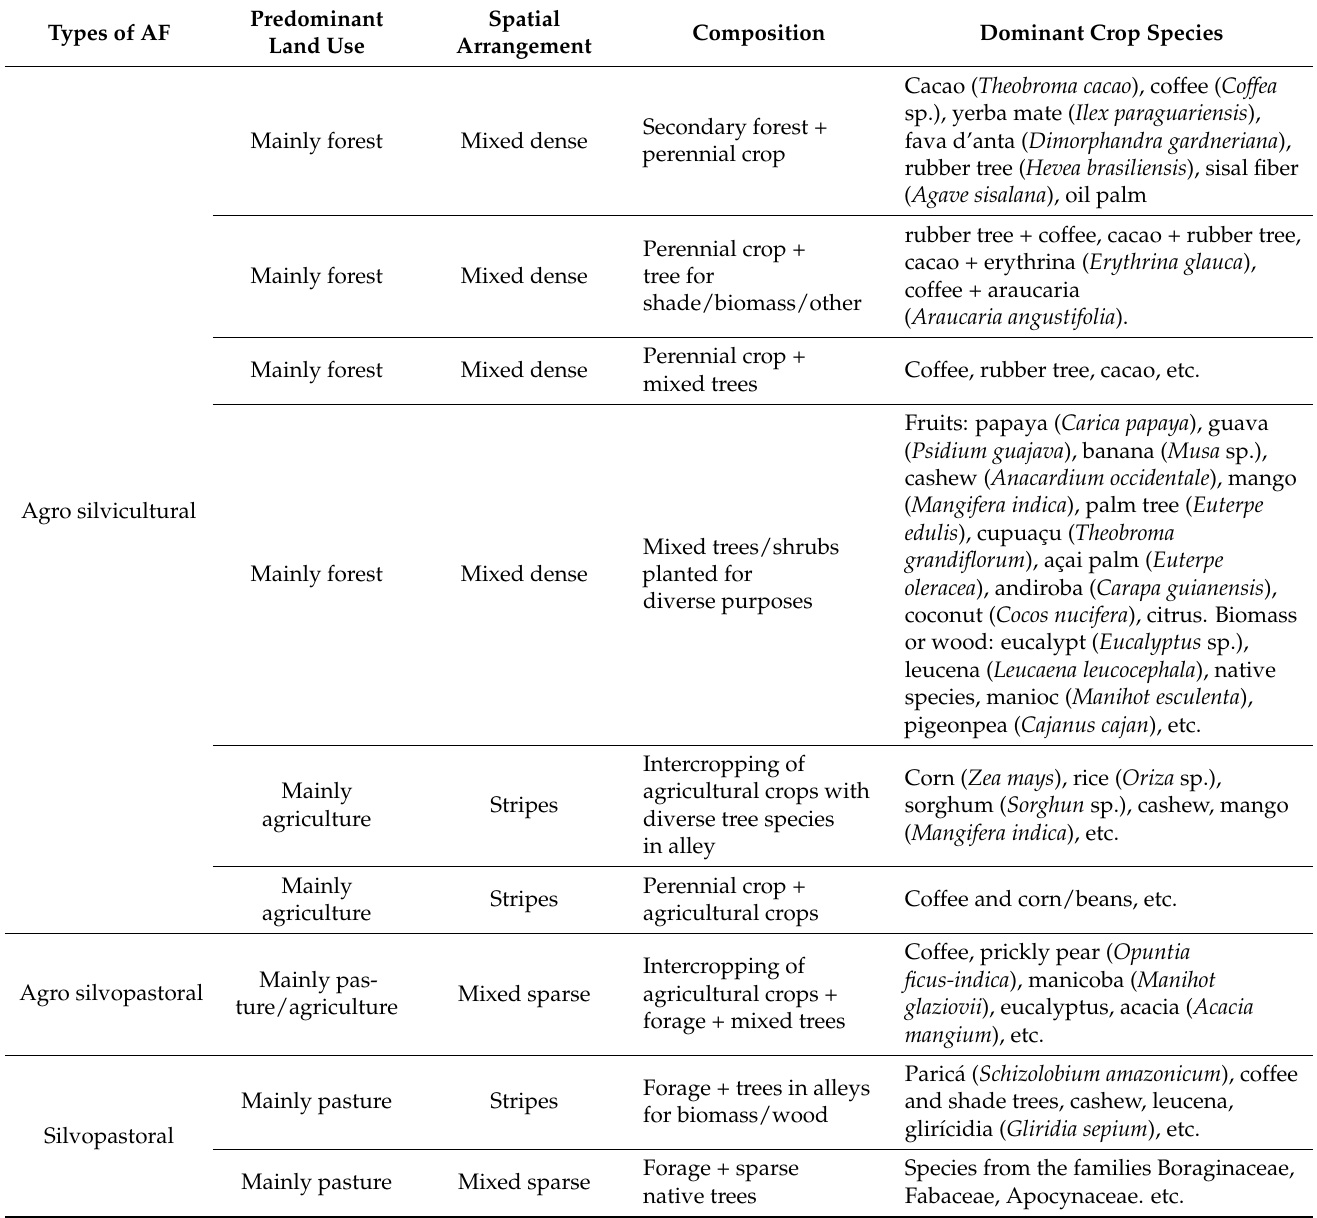
Table 1. Examples of agroforestry types assessed in the